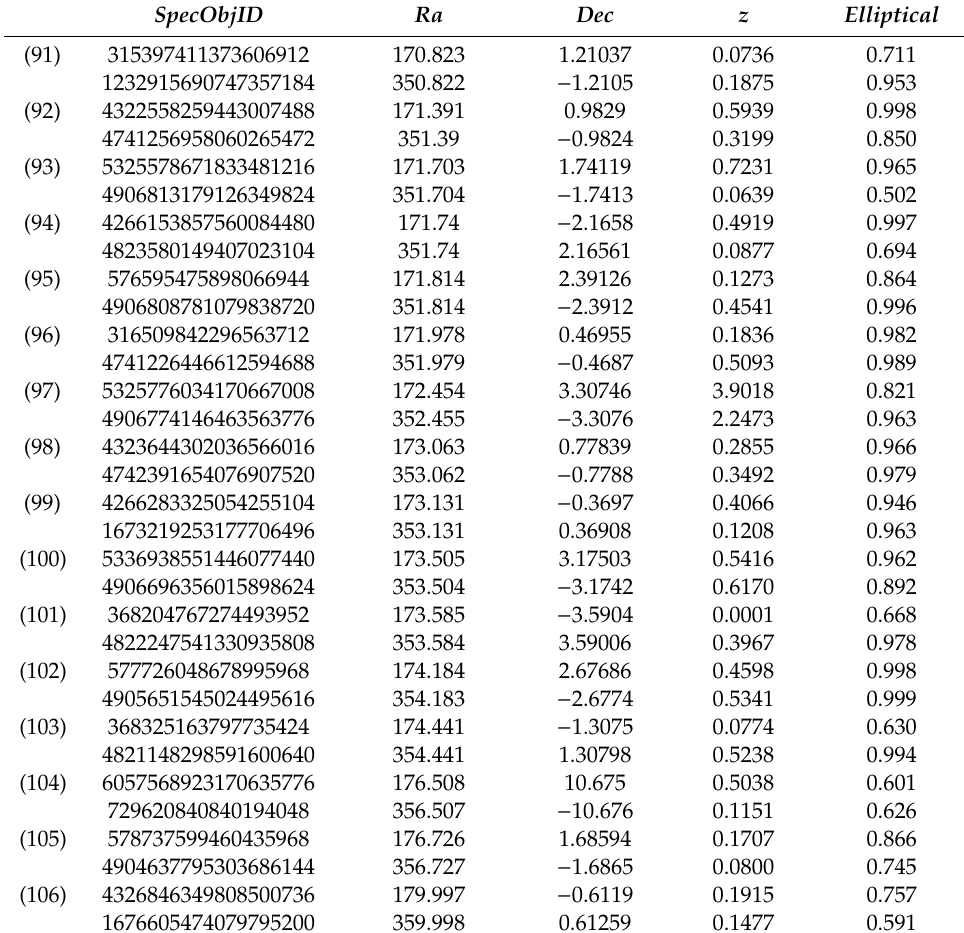
Table A8. Pairs of spiral galaxies (with parameter spiral > 0.5) for the e ff ect of cosmic lens [39].